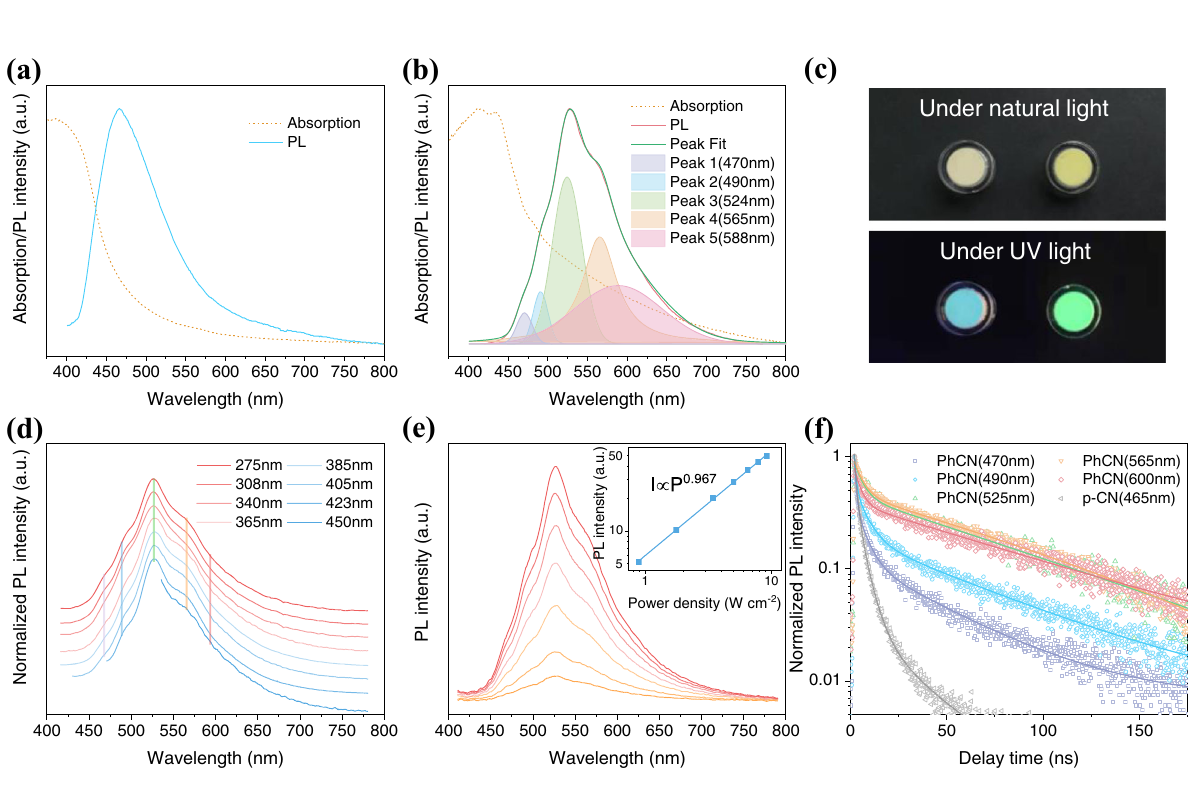
excitation light. e PL spectra of PhCN under 385nm excitation light with different intensities, (inset: power-dependent curve of luminescence intensity). f PL decay pro fi les of p-CN and PhCN under a 375nm picosecond